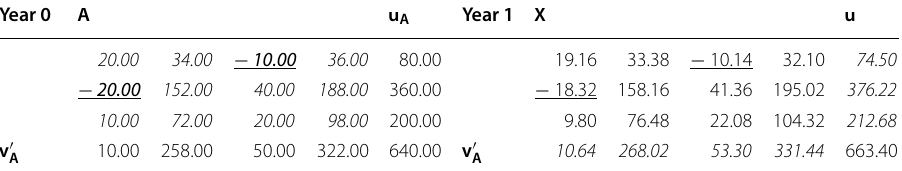
Table 10 Initial matrix with negative entries and the target marginal totals Year